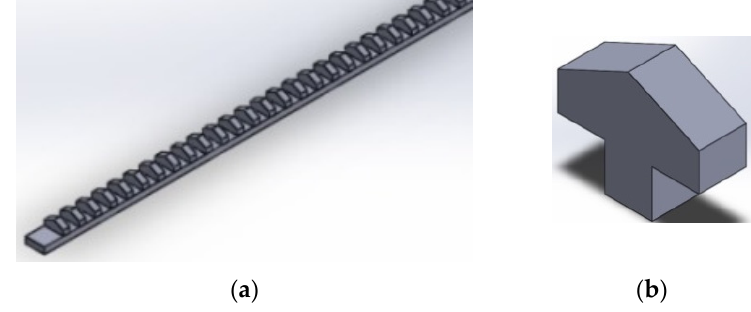
Figure 3. ( a ) The loop threshing bar and ( b ) a threshing tooth.